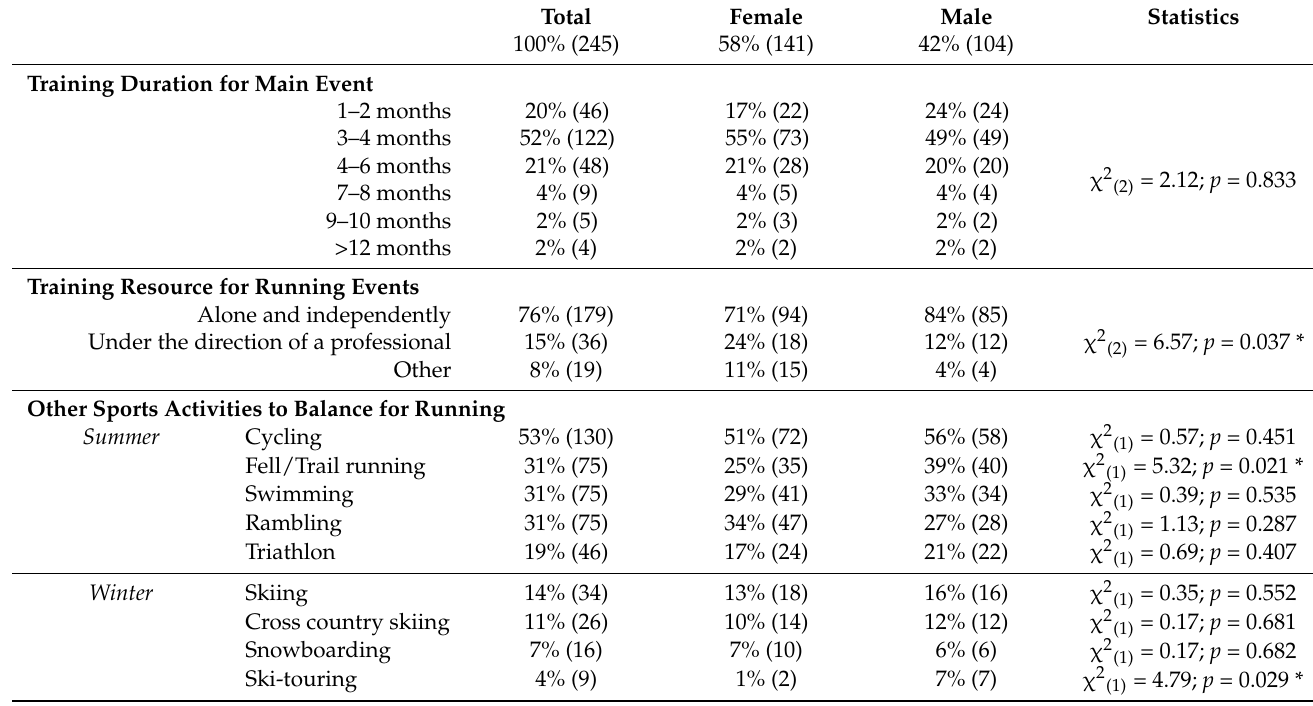
Table 2. General Training Behaviors, including Total Duration, Resource, and Other Sports by Sex.